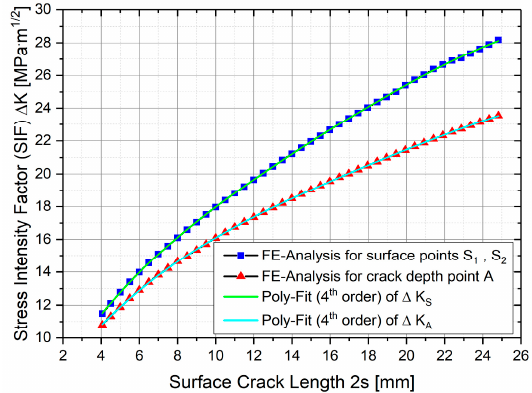
Figure 8. Stress intensity factor of the surface points ( S 1 and S 2 ) and the depth (point A ) as a function of the surface crack length 2s .